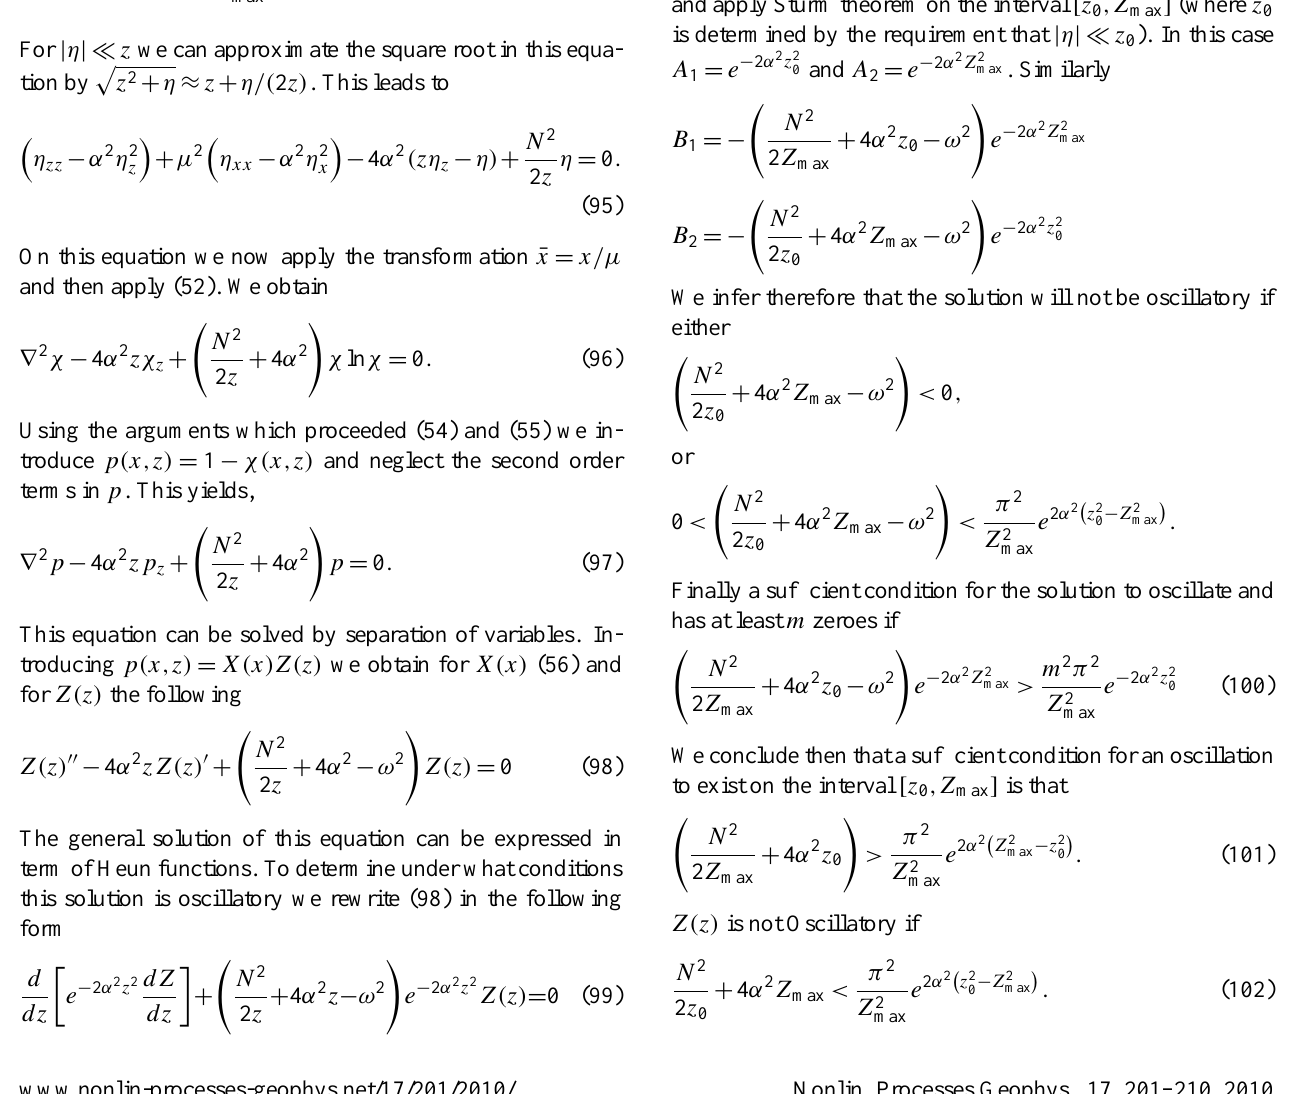
Fig. 4. A plot of the left hand of the inequality (89) (solid line) versus the right hand side (dotted line) when N = 0, β = 0 . 025 and δ = 0 as a function of Z max .